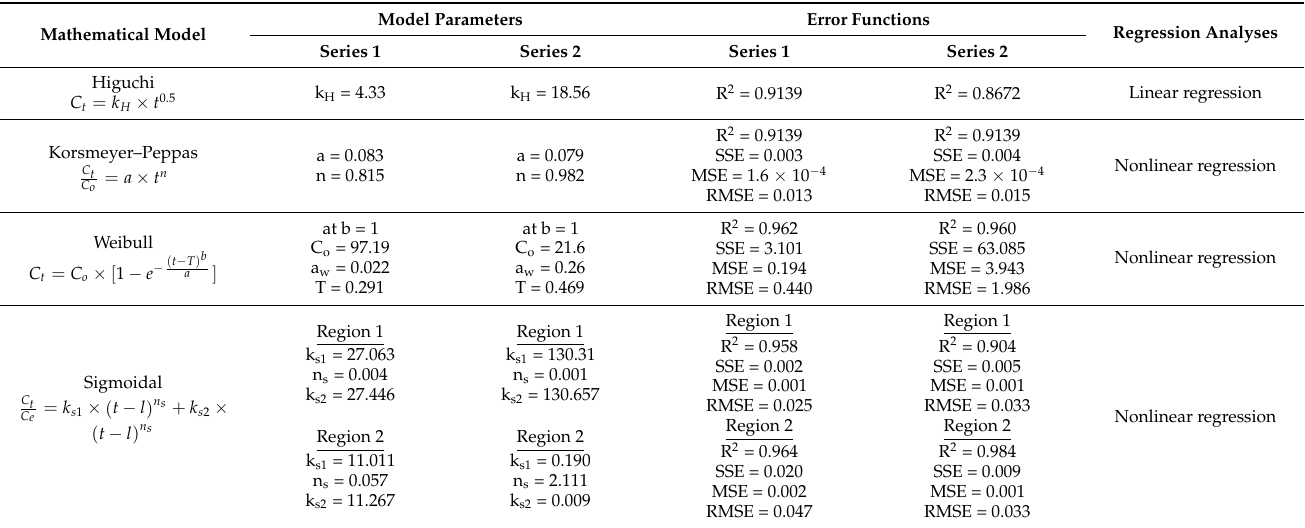
Table 2. Values of the model parameters and error functions of the applied in vitro release kinetics models to the doxycycline/animal feed system in simulated gastrointestinal and stomach